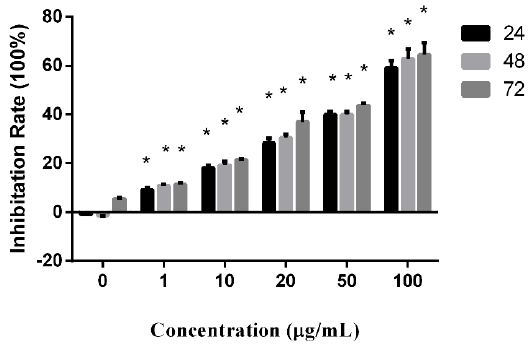
Figure 2. Effect of peperomin E on cell proliferation as determined by MTT assay. * P < 0.05 Figure 2. E ff ect of peperomin E on cell proliferation as determined by MTT assay. * P <